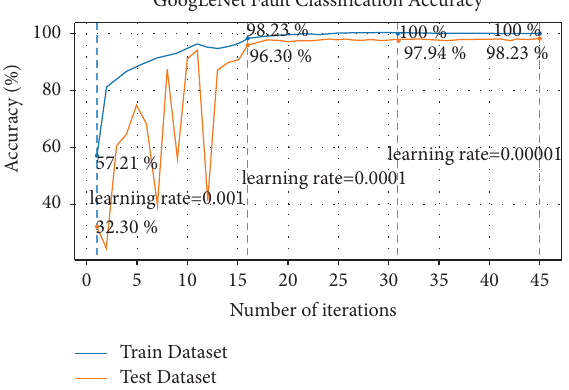
Figure 16: Faults classifcation